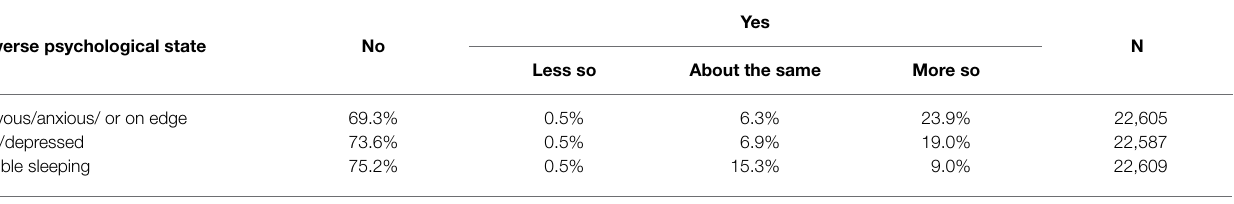
Yes Less so About the same More so